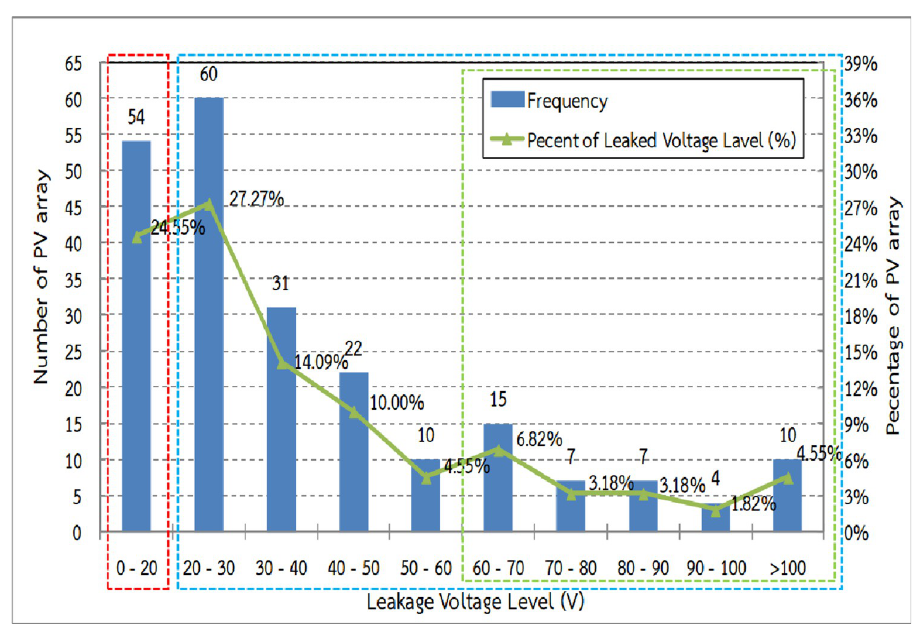
Fig 7. Leakage voltage distribution of sampled